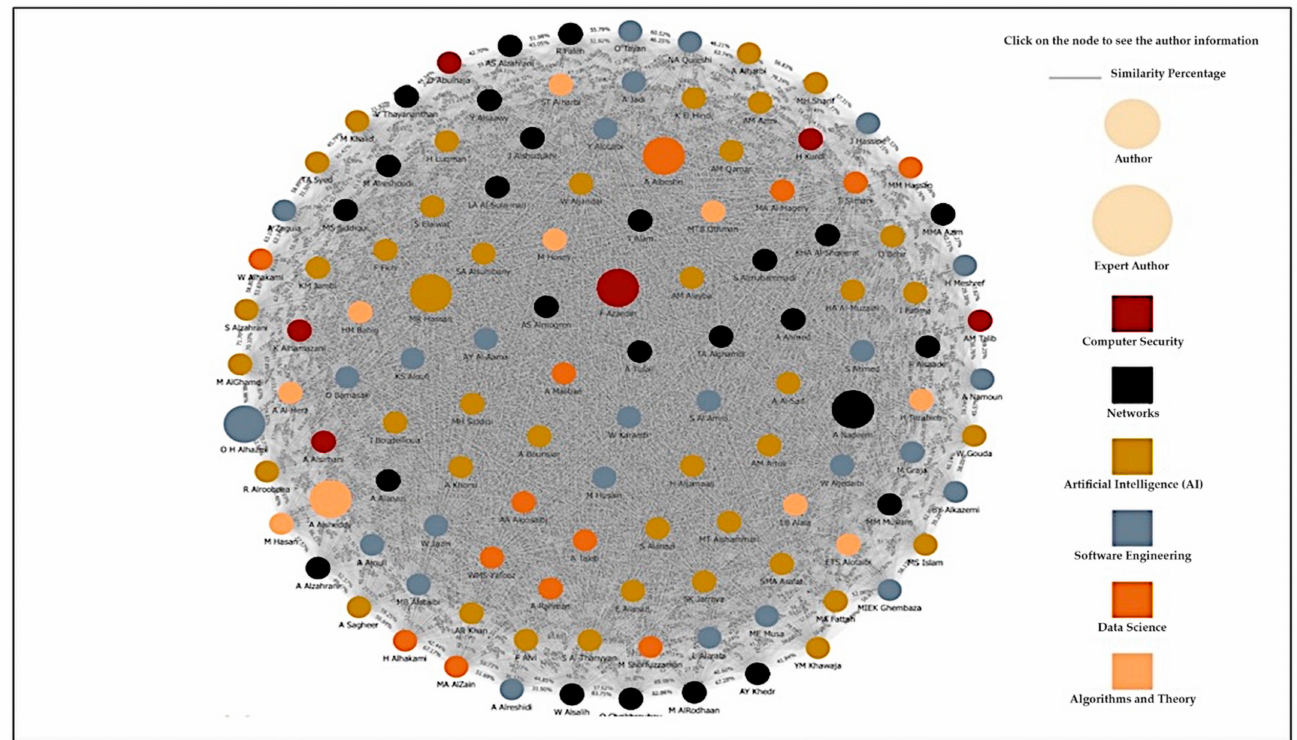
Figure 19. The authors’ collaboration